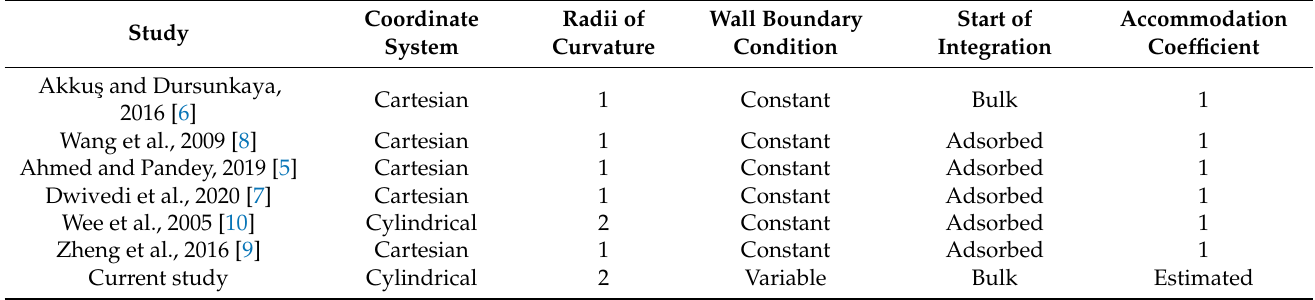
Table 1. Summary of prior and current approaches of modeling evaporation at the thin film.